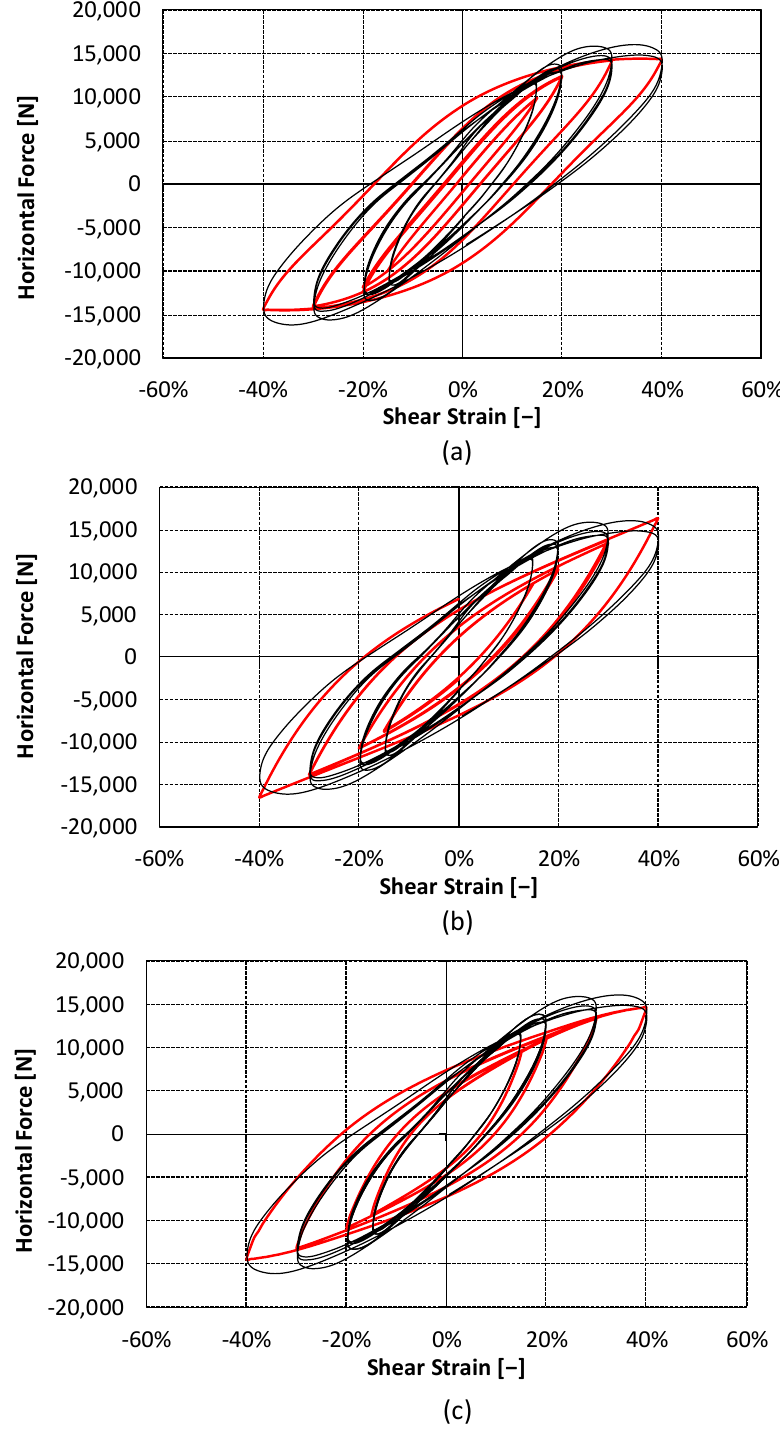
Figure 7. Differential Evolution Algorithm. Numerical Analysis vs Test Data, ( a ) BOUC–WEN Element, ( b ) HDR Element and ( c ) Kikuchi Bearing Element.